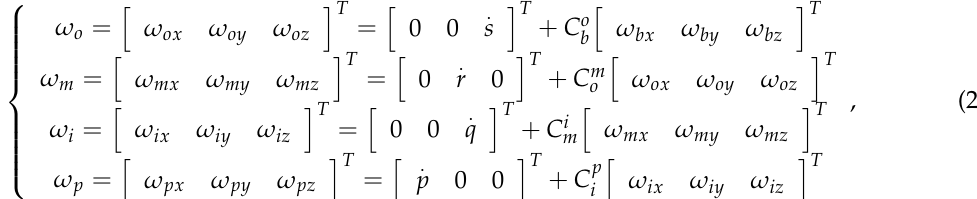
Figure 5. Four-gimbal platform coordinate system definition [37].